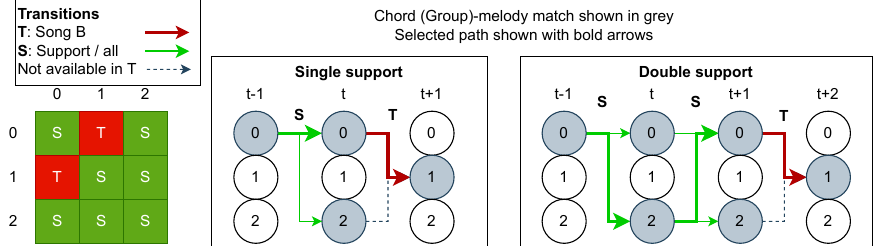
Figure 1. In a simplified example, a “universe” of three chords (equivalent to groups in the presented approach) is considered. T includes the transitions of Song B, which incorporate only chords 0 and 1, and transitions are only possible from one to the other (not to themselves). The “support” space includes all three chords, and transitions are possible between all chords ( S also includes the probabilities of T ). Some melodic segments are compatible with some chords at time step t + i (as in O N × K ); compatible chord-melody matches are indicated in grey, incompatible in white. In case a single support transition probability is used, S is only employed to facilitate a transition between chords 0 and 1, which is not possible in T ; all other paths will be eventually erased by backtracking. If double (or multiple consecutive) supports are employed, then all supports, except from the final in the series, could possibly incorporate chord 2, which is not available in Song